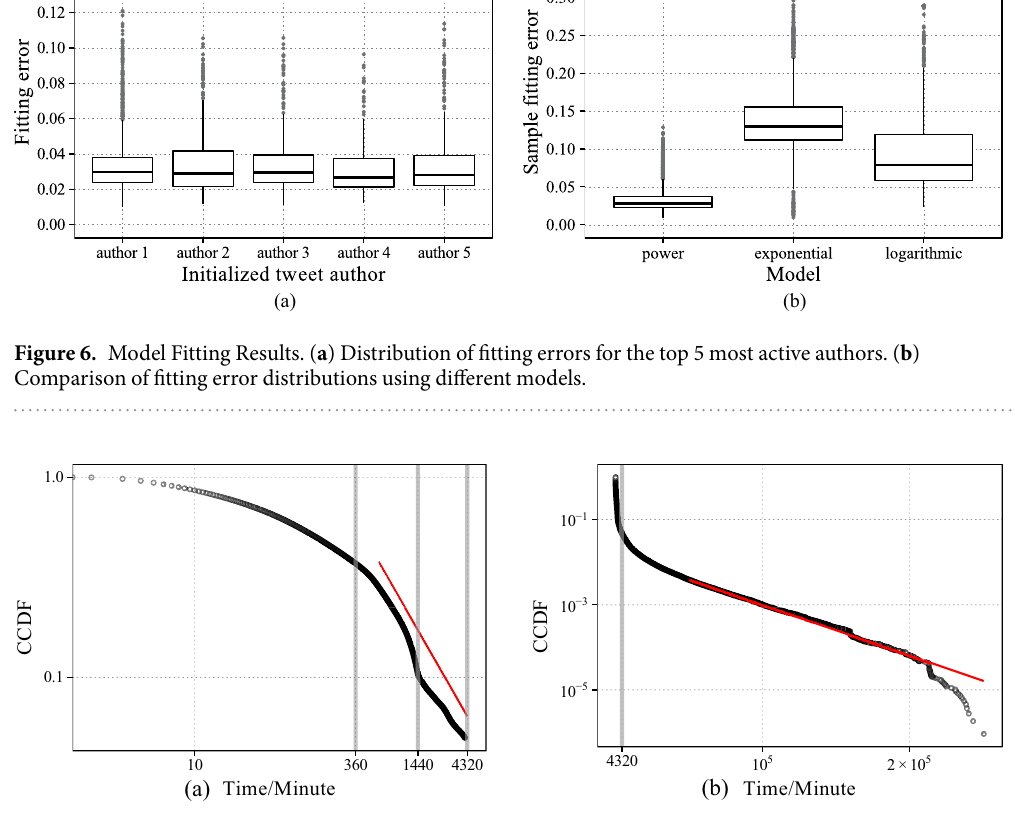
Figure 7. Complementary Cumulative Distribution Function (CCDF) of the waiting time for retweeting. ( a ) The distribution of τ within a relatively small time span. The tail is approximately a straight line. ( b ) The distribution of τ at a larger time span. The tail is likely to be